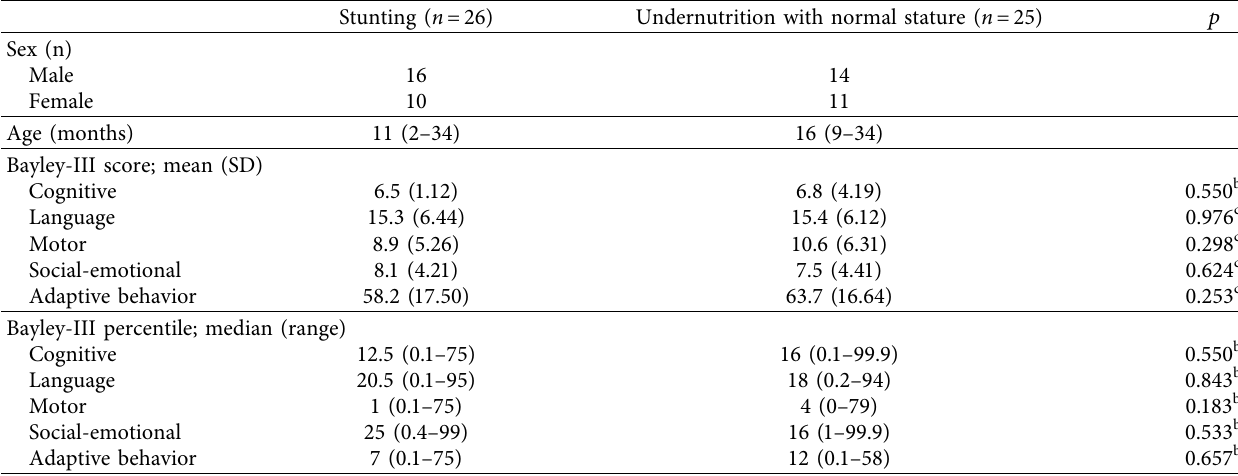
Table 1: Comparison of Bayley-III scores of children with stunting and undernutrition with normal